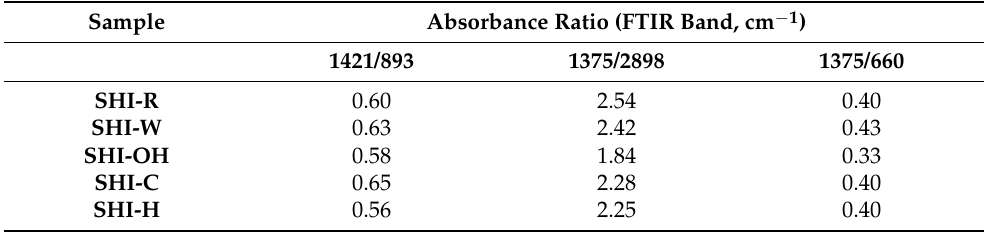
Table 3. The crystallinity index of raw (SHI-R) and treated hemp shives (SHI-W, SHI-OH, SHI-C and SHI-H) obtained using ATR-FTIR spectroscopy. The ratios of the peaks at 1421 and 893, 1375 and 2898 and 1375 and 660 cm − 1 were used to measure relative cellulose